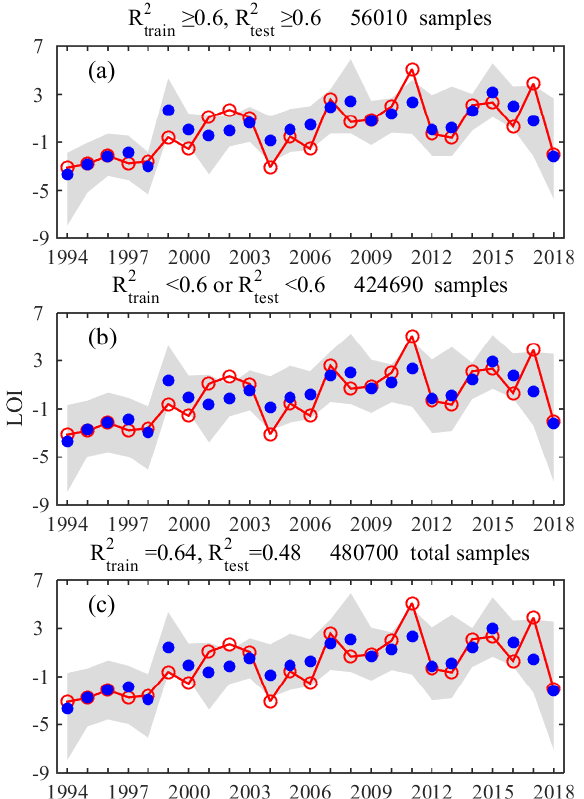
Figure A3. Combined fitting results of the regression models with different combinations of training and testing datasets. R 2 values in (a) were greater than or equal to 0.6 both in the training and testing datasets. R 2 values in (b) were less than 0.6 both in the training and testing datasets. Fitting results of total samples were in (c) . Note that the hollow red dots denote the LOI estimated based on observational data, while the solid blue dots and the gray patch represent the mean values and ranges of the fitted LOI in the selected regression cases, respectively.